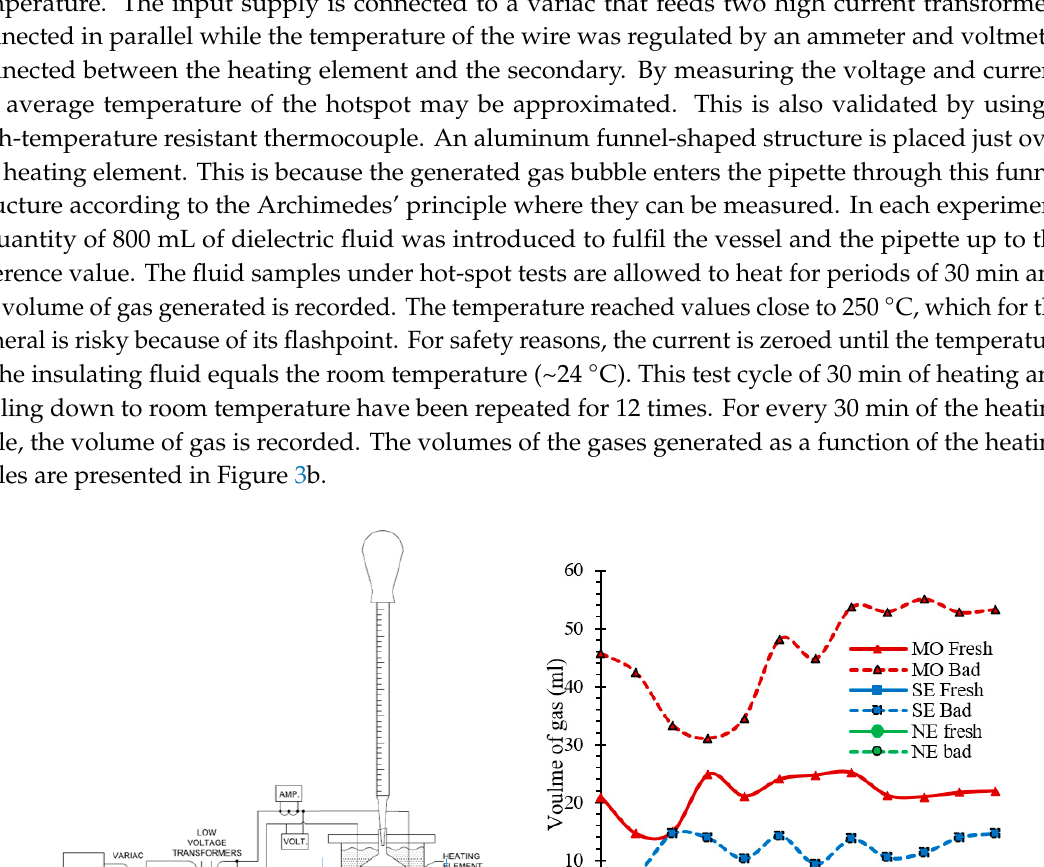
Table 4. List of abbreviations. Abbreviation